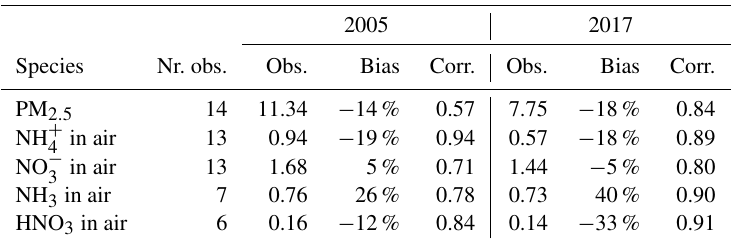
Table A1. Year 2005 and year 2017 statistics for scatter plots with common measurement sites for both years. Obs is observed annual mean for the sites. Bias is model bias, and Corr. is correlation between measurements and the model